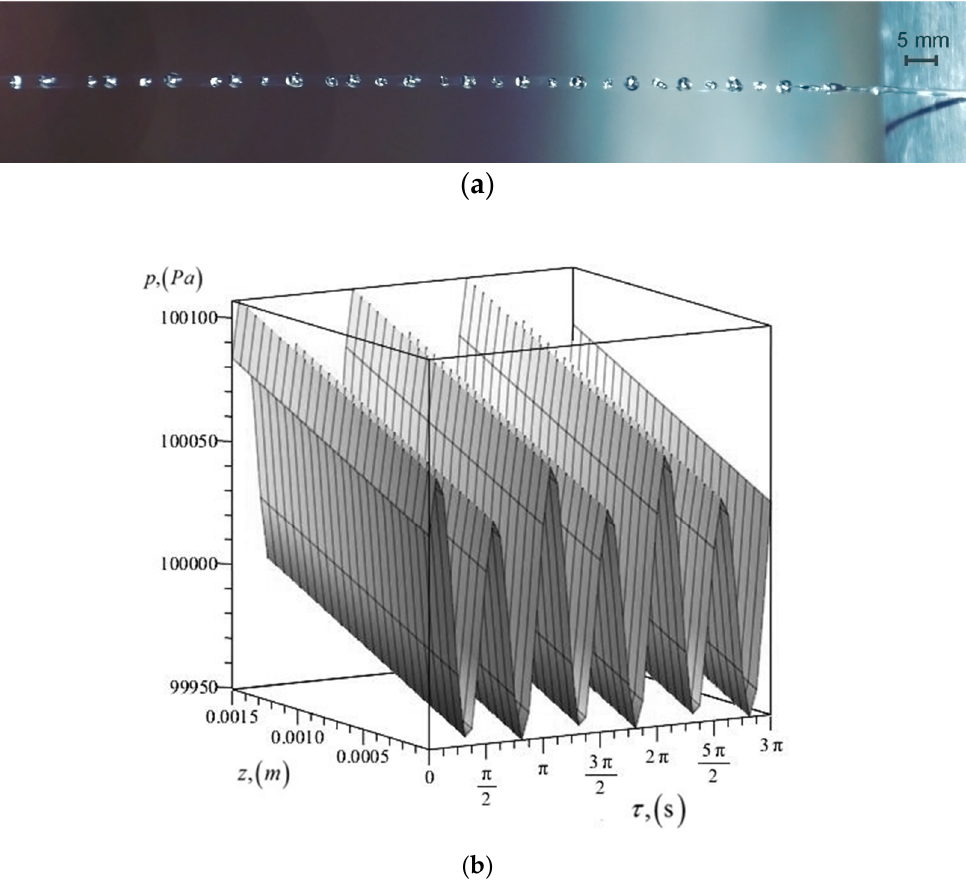
Figure 4. Study results of the jet at a signal frequency of 220 Hz, and amplitude of 100 μ m: ( a ) physical experiment; ( b ) theoretical calculation using the Equation (8).